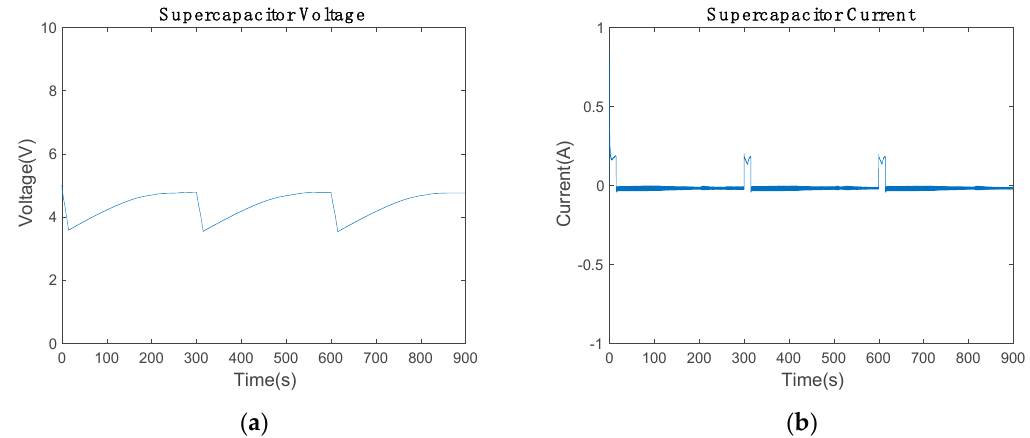
Figure 12. Supercapacitor’s state during the communication: ( a ) voltage and ( b ) current of the supercapacitor.